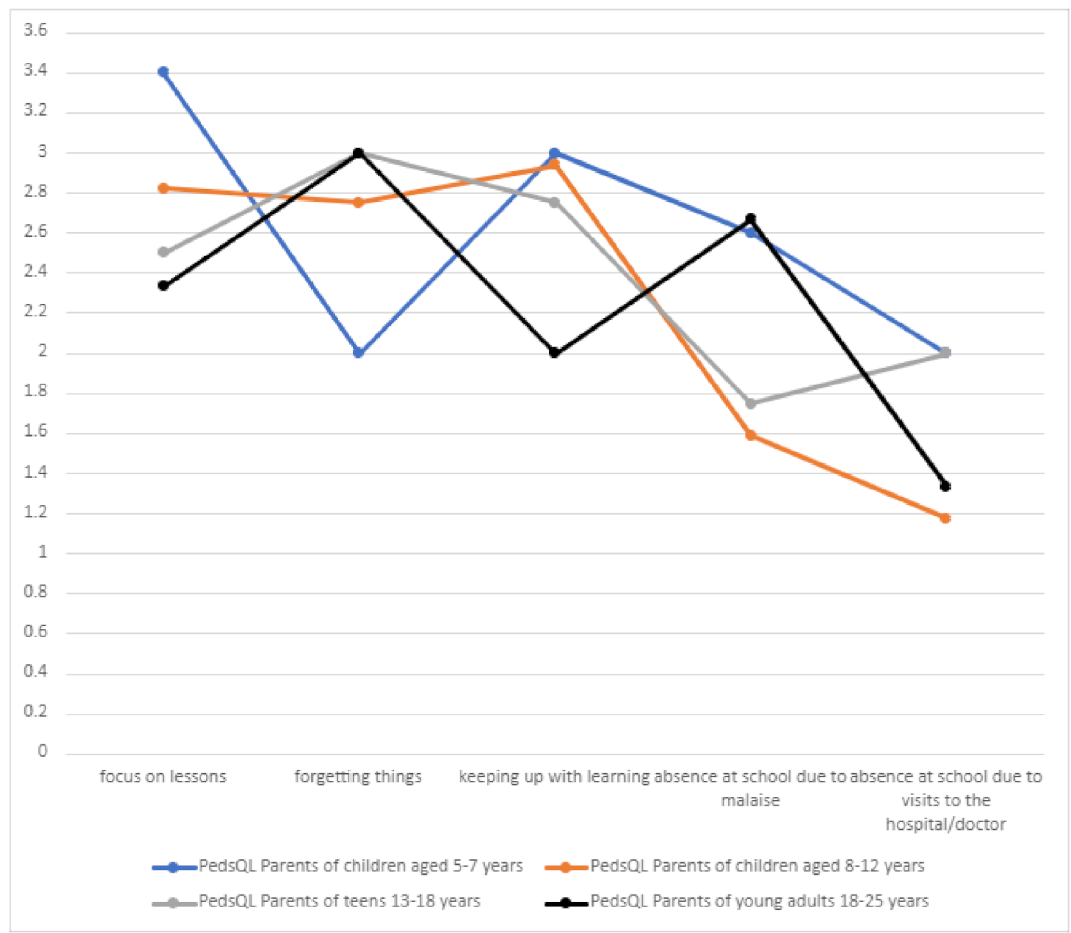
Figure 14. School functioning in children with